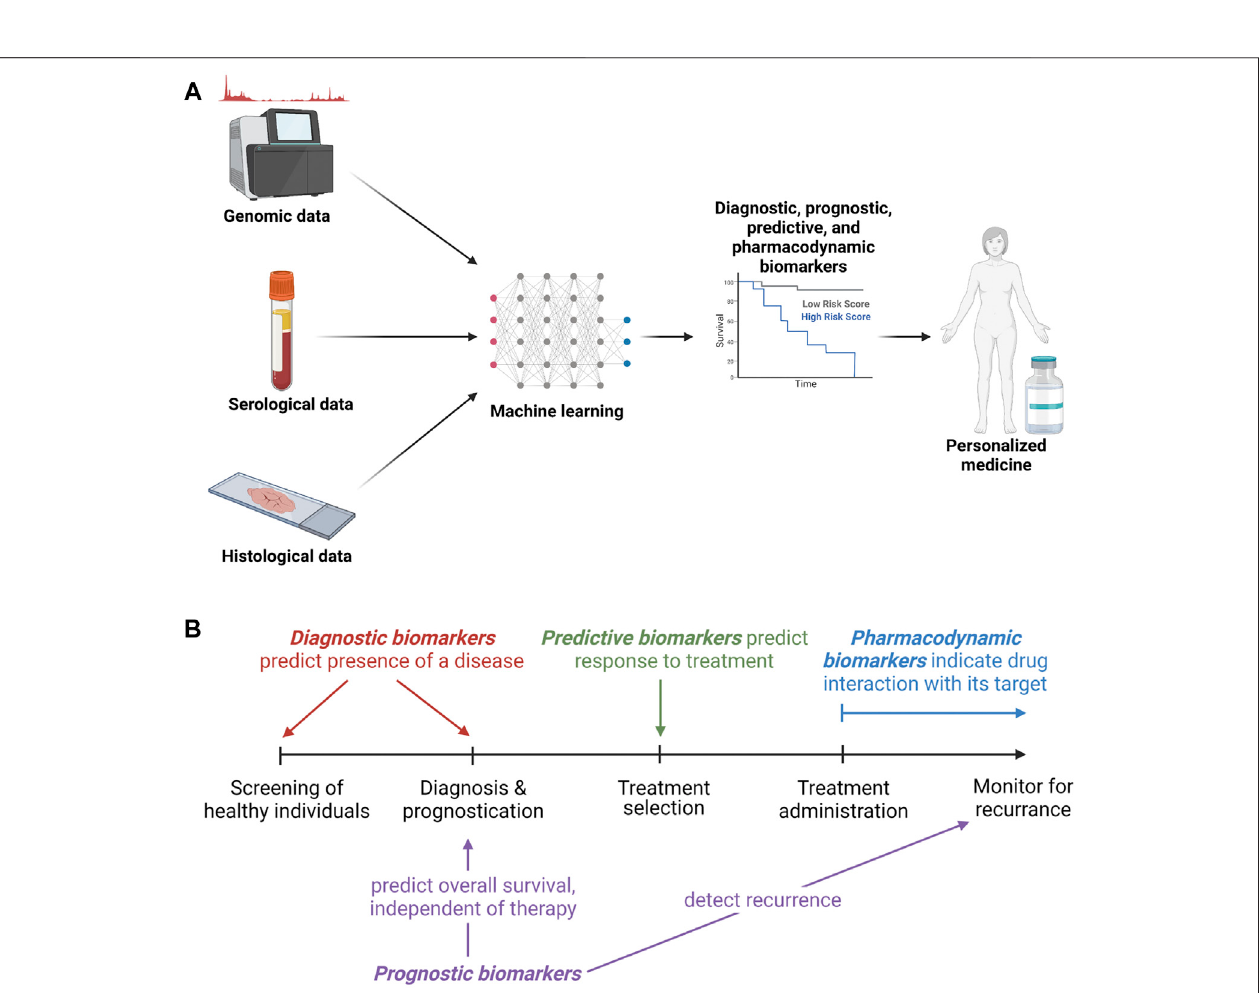
FIGURE2| Biomarkerdevelopmentandclinicalutility. (A) .Overviewofmethodsofbiomarkerdevelopment,testingandclinicalutilization. (B) .Typesofbiomarkers with a timeline of opportunities for utilization.